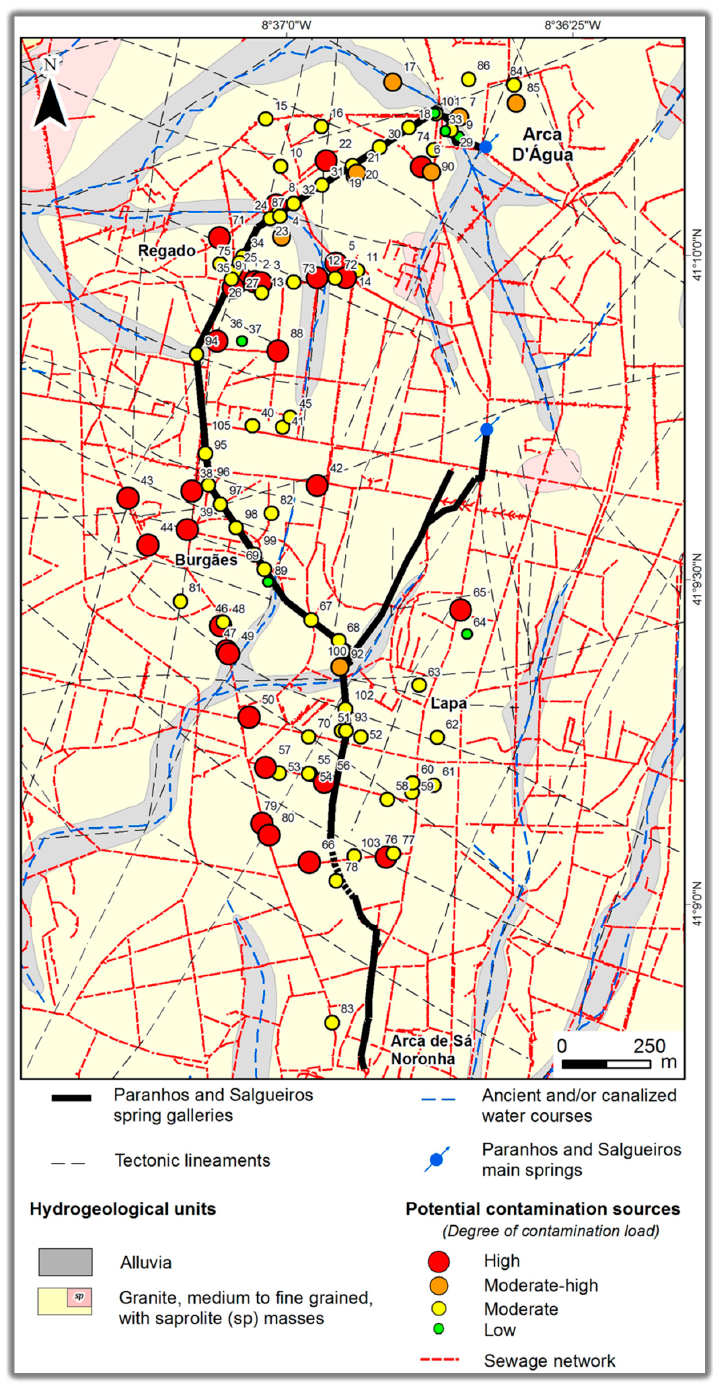
Figure 3. Hydrogeological units and potential contamination sources around Paranhos and Salgueiros spring galleries.